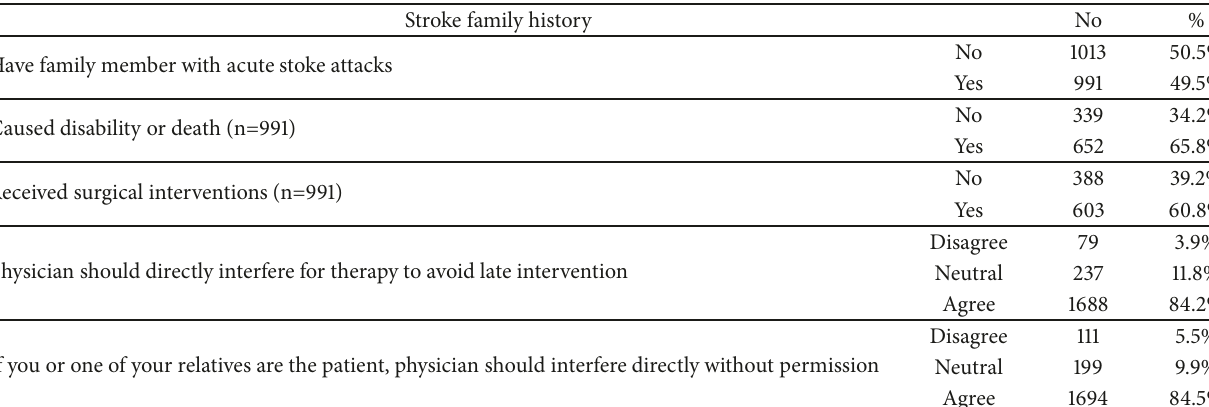
Table 2: Stroke family history among general population shared in preference and values of stroke intervention, Kingdom of Saudi Arabia, 2018. Stroke family